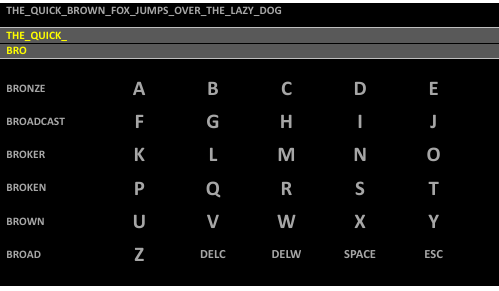
Figure 9. Two different layouts designed for predictive spelling. ( a ) The predicted words are displayed on the left side of the screen over an ―extra‖ window in the interface, thus requiring keeping them in the user’s memory, which could increase the cognitive workload. Adapted from [114]. ( b ) The solution proposed to alleviate the cognitive workload by integrating the suggested words into the interface as selectable